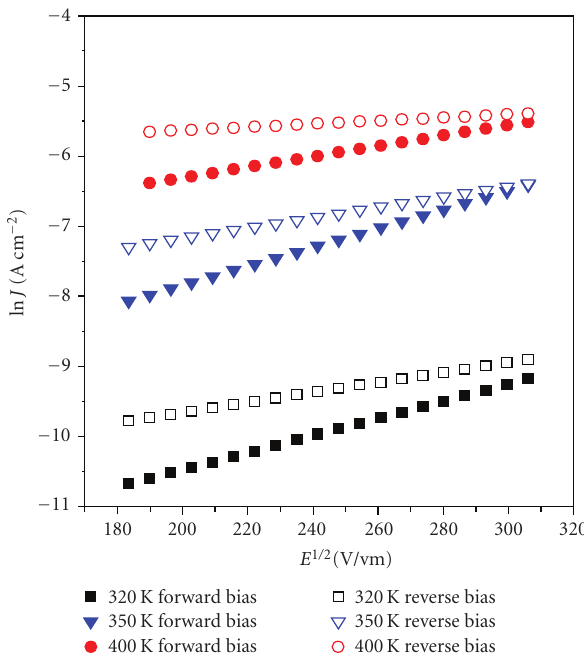
Figure 4: Semilogarithmic plots of ln J versus E 1 / 2 for the high field of 10 4 –10 5 V/cm in forward bias (increasing electric field) and reverse bias (decreasing electric field) and poling temperature range 320 K–370K (R-reverse bias; F-forward